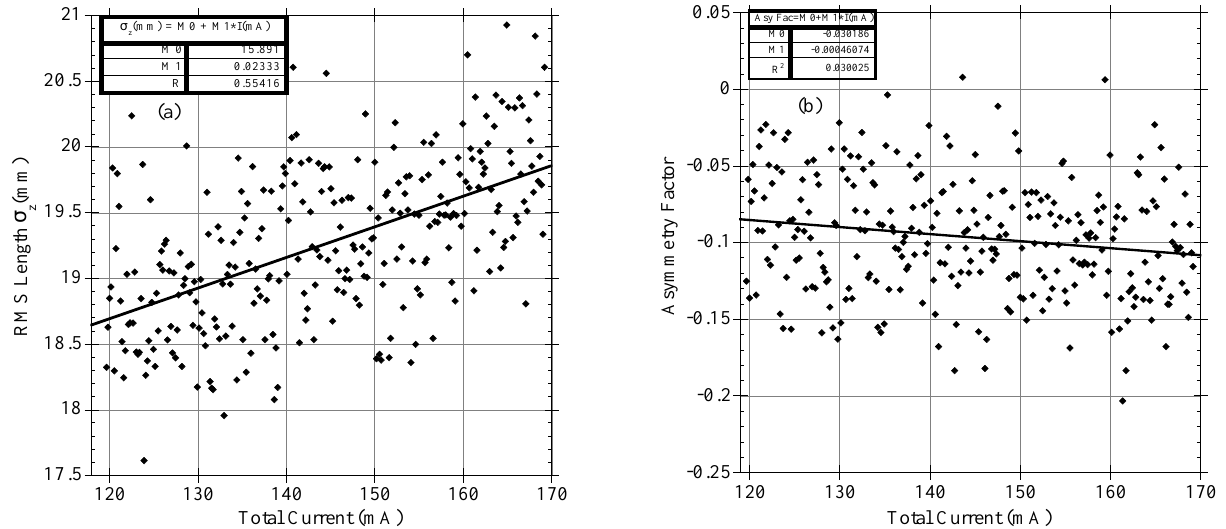
FIG. 9. (a) The electron bunch length and (b) asymmetry factor as a function of current during high-energy collisions in CESR. The fit to the data is linear and points out the slow decrease in the bunch length and asymmetry factor as a function of current. The rf accelerating voltage during the measurement was 6.49 6 0.01 MV.